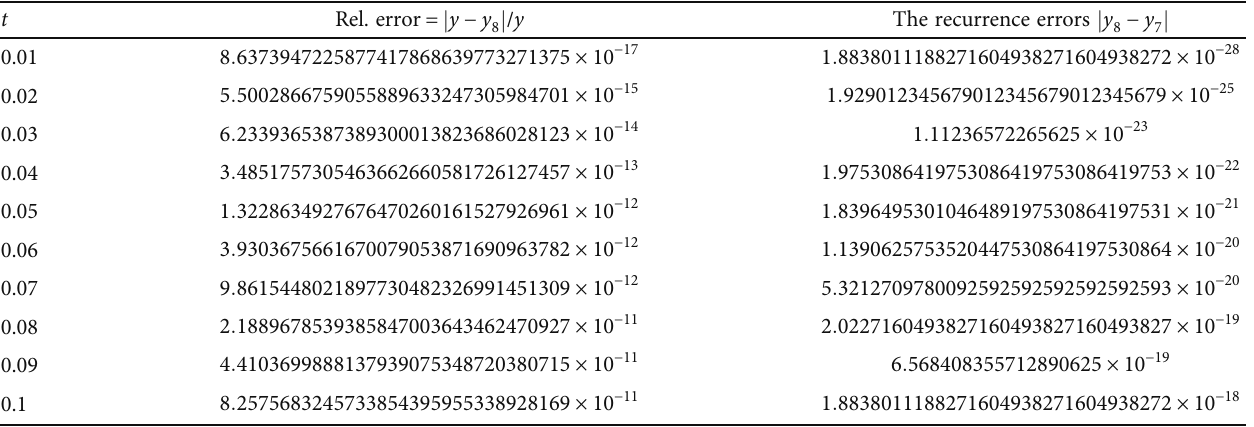
Table 10: Relative error = j y − y Example 3.